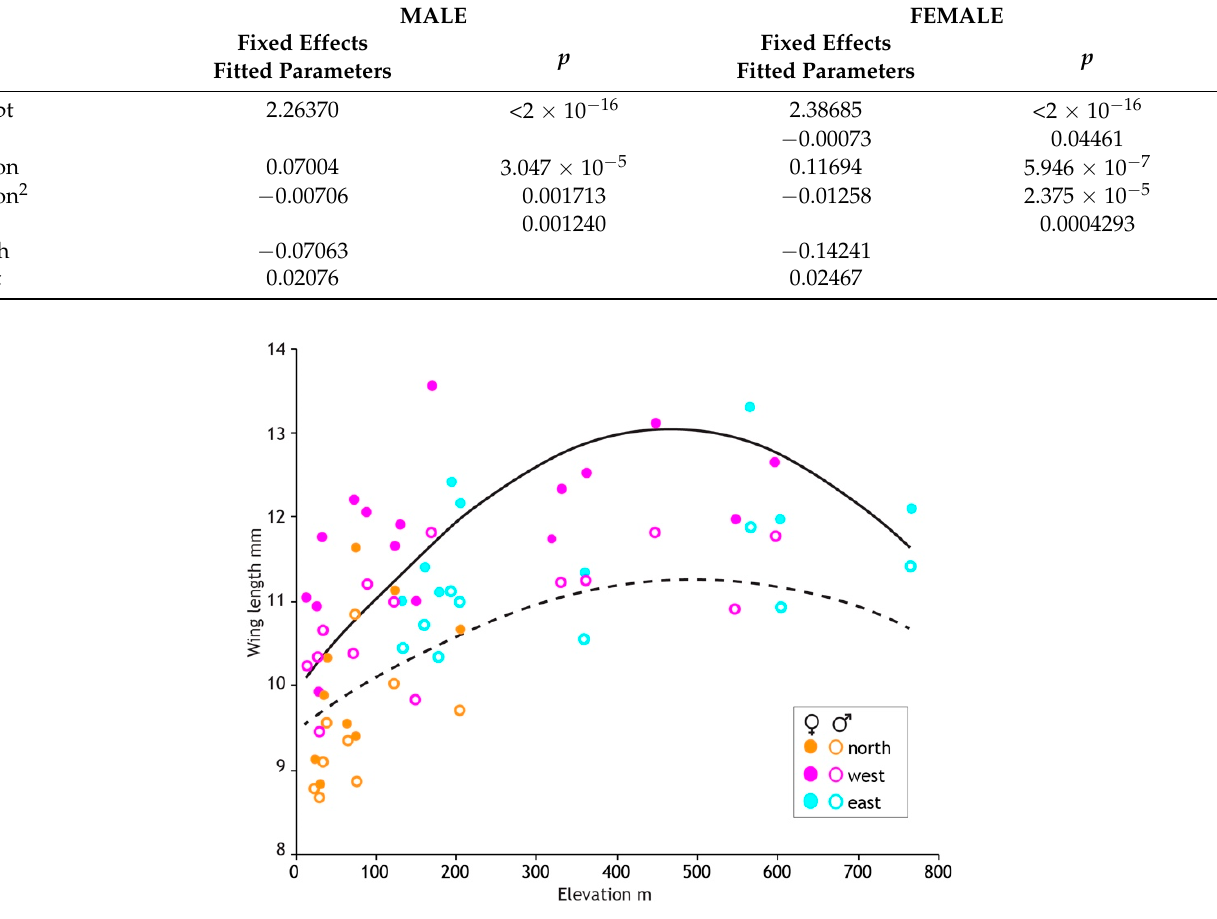
Figure 8. Three geographical regions defined by genetics reveal intraspecific size variation in the New Zealand mayfly Acanthophlebia cruentata. Average wing length and elevation (metres above sea level) at each of 33 sampling sites (N = 1064). Fitted lines (female solid, male dashed) are from the linear mixed effects models evaluated at average values of other covariates.